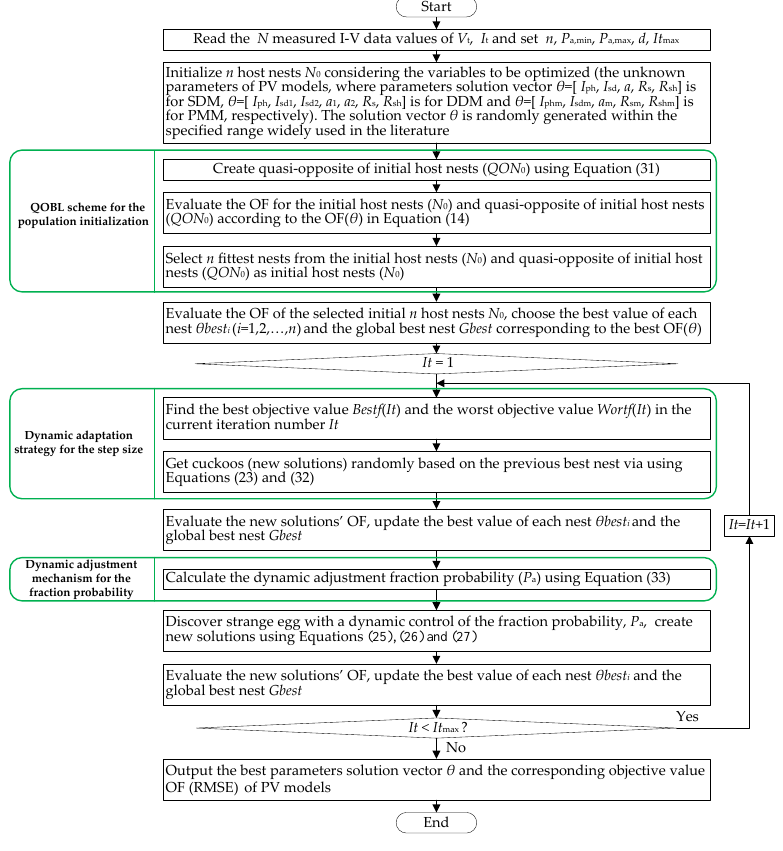
Figure 3. The flowchart of the procedure of employing the proposed ImCSA for solving the PV models parameter estimation problem.